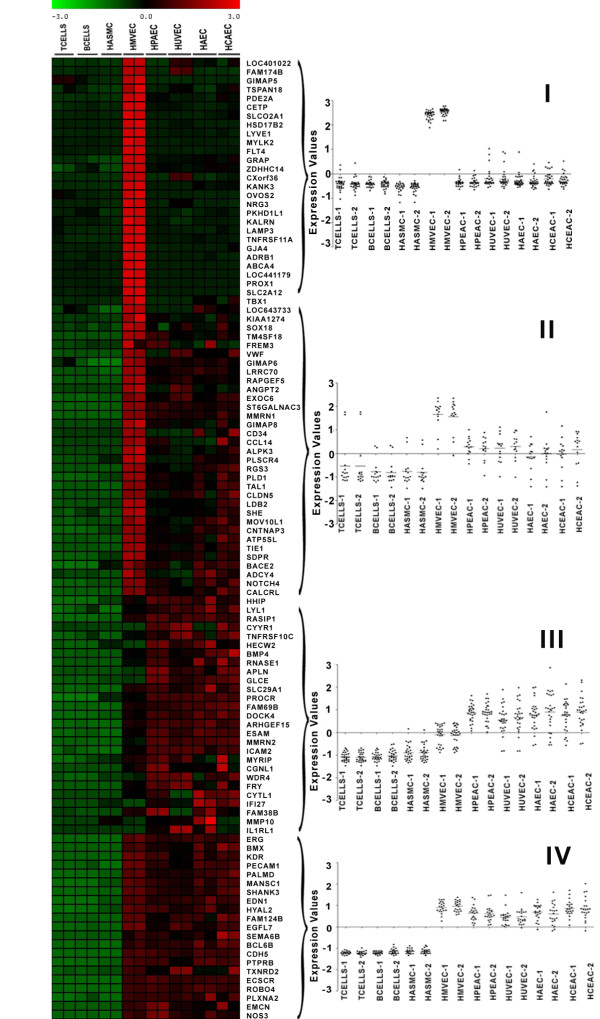
Colorgram depicting the expression of EC-restricted genes in different cell types in the primary set. The columns represent the samples and rows represent the genes. Gene expression is shown with a pseudocolor scale (-3 to 3) with red color denoting high expression level and green color denoting low expression level of the gene. The scatter plots along the heatmap depict the different patterns in expression of EC-restricted genes obtained using K mean clustering. The K mean clusters are represented as scatter plots with bars denoting the mean expression level. Pattern I and IV depict a range of expression patterns exhibited by EC-restricted genes. For example pattern IV and I denotes the genes that are highly expressed in all endothelial cell types (pan EC) and HMVEC cells respectively.